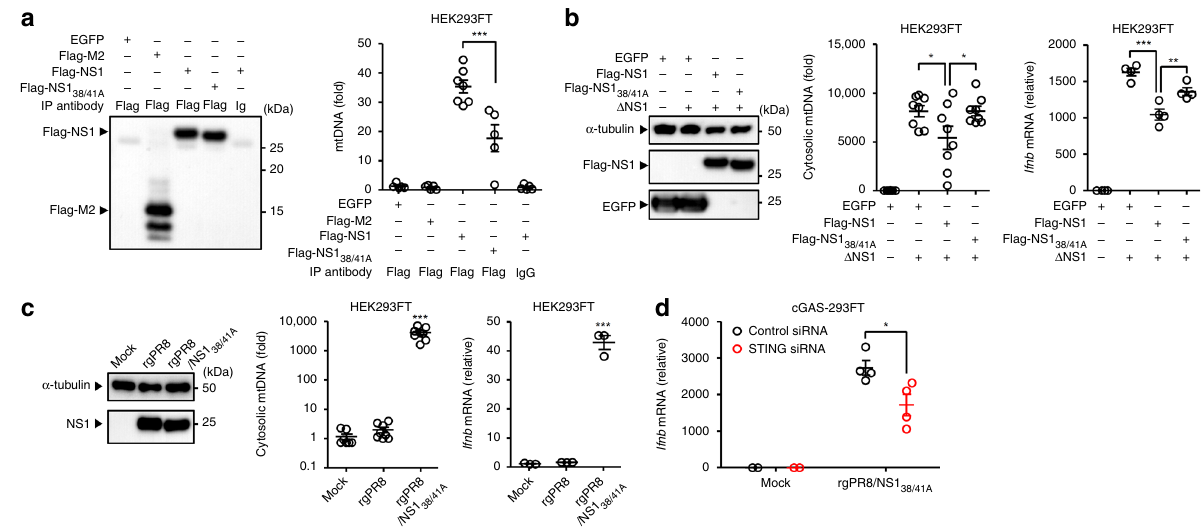
Fig. 6 In fl uenza virus NS1 protein associates with mtDNA. a HEK293FT cells were transfected with the expression plasmid encoding EGFP, Flag-tagged M2, NS1, or NS1 38/41 mutant. Twenty-four hours after transfection, the cells were infected with Δ NS1 in fl uenza virus for 24 h. Pure cytosolic extracts prepared from digitonin extracts of Δ NS1 in fl uenza virus-infected cells were immunoprecipitated with mouse monoclonal antibody against Flag, followed by immunoblotting of immunoprecipitates with rabbit polyclonal antibody against Flag (left panel). DNA was extracted from immunoprecipitated samples using QIAquick Nucleotide Removal kit (QIAGEN). NS1-bound mtDNA was assessed by quantitative PCR (right panel). b HEK293FT cells were transfected with the expression plasmid encoding EGFP, Flag-tagged NS1, or NS1 38/41 mutant. Twenty-four hours after transfection, the cells were infected with Δ NS1 in fl uenza virus for 24 h. Cell lysates were collected and blotted using the indicated antibodies (left panel). Cytosolic mtDNA was assessed by quantitative PCR (middle panel). IFN- β mRNA levels were assessed by quantitative PCR with β -actin as an internal control (right panel). c HEK293FT cells were infected with WT (rgPR8) or rgPR8/NS1 38/41A in fl uenza virus at MOI of 1 for 24 h. Cell lysates were collected and blotted using the indicated antibodies (left panel). Cytosolic mtDNA (middle panel) and IFN- β mRNA levels (right panel) were assessed by quantitative PCR. d cGAS-293FT cells transfected with siRNA targeting STING or control siRNA were infected with rgPR8/NS1 38/41A in fl uenza virus for 24 h. IFN- β mRNA levels were assessed by quantitative PCR with β -actin as an internal control. These data are from three independent experiments (mean± s.e.m.). * P < 0.05, ** P < 0.01, *** P < 0.001; (one-way ANOVA